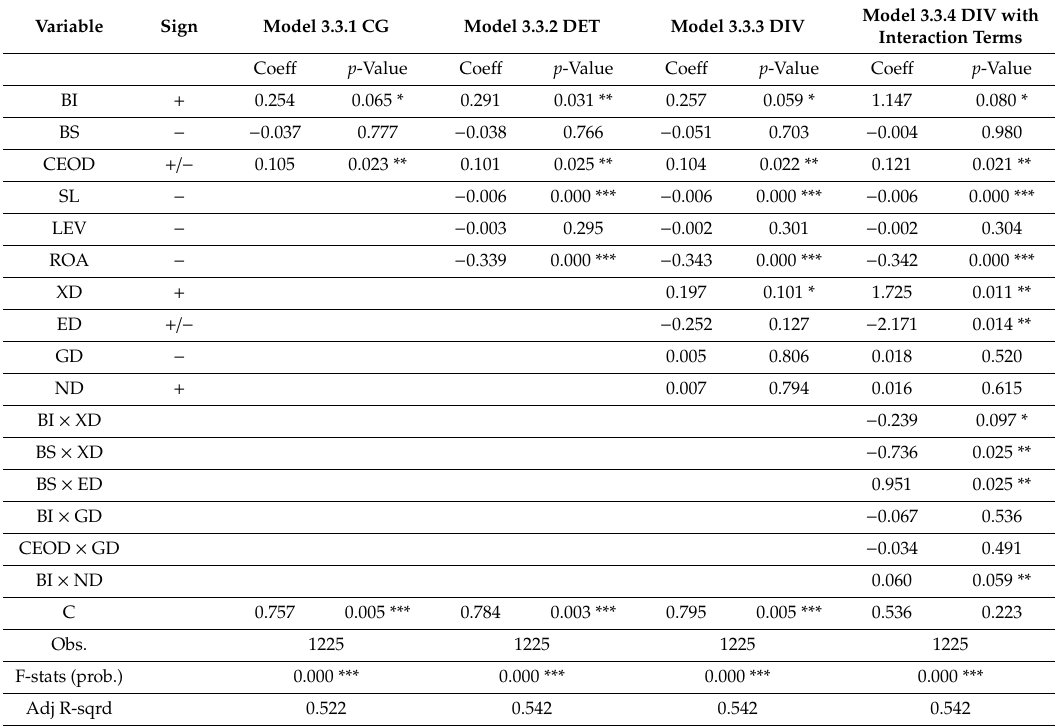
Table 5. Impact of conventional accounting variables, corporate governance, and board diversity on investment decisions (Sample Size = 175, N =